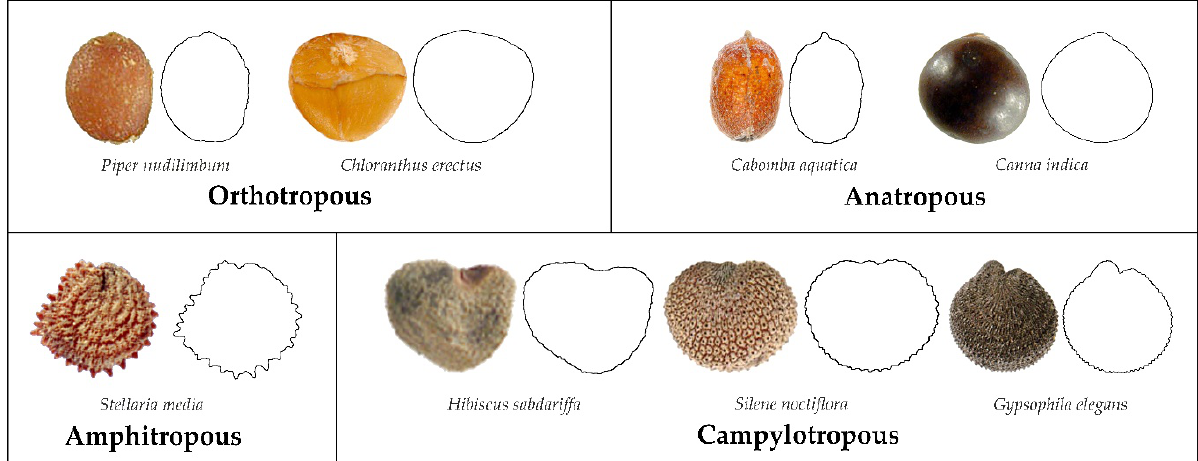
Figure 5. Seed images and their corresponding silhouettes from species with diverse ovule types. Above: Orthotropous: Piper nudilimbum C.DC. (Piperaceae); Chloranthus erectus (Buch.-Ham.) Verdc. (Chloranthaceae). Anatropous: Cabomba aquatica Aubl. (Cabombaceae); Canna indica L. (Cannaceae). Below: Amphitropous: Stellaria media (L.) Vill. (Caryophyllaceae). Campylotropous: Hibiscus sabdariffa L. (Malvaceae); Silene noctiflora L. (Caryophyllaceae); Gypsophila elegans M. Bieb. (Caryophyllaceae). The images were obtained and modified from [57], except S. media (https://plants.usda.gov/home/plantProfile?symbol=STME2; accessed on 19 October 2022).